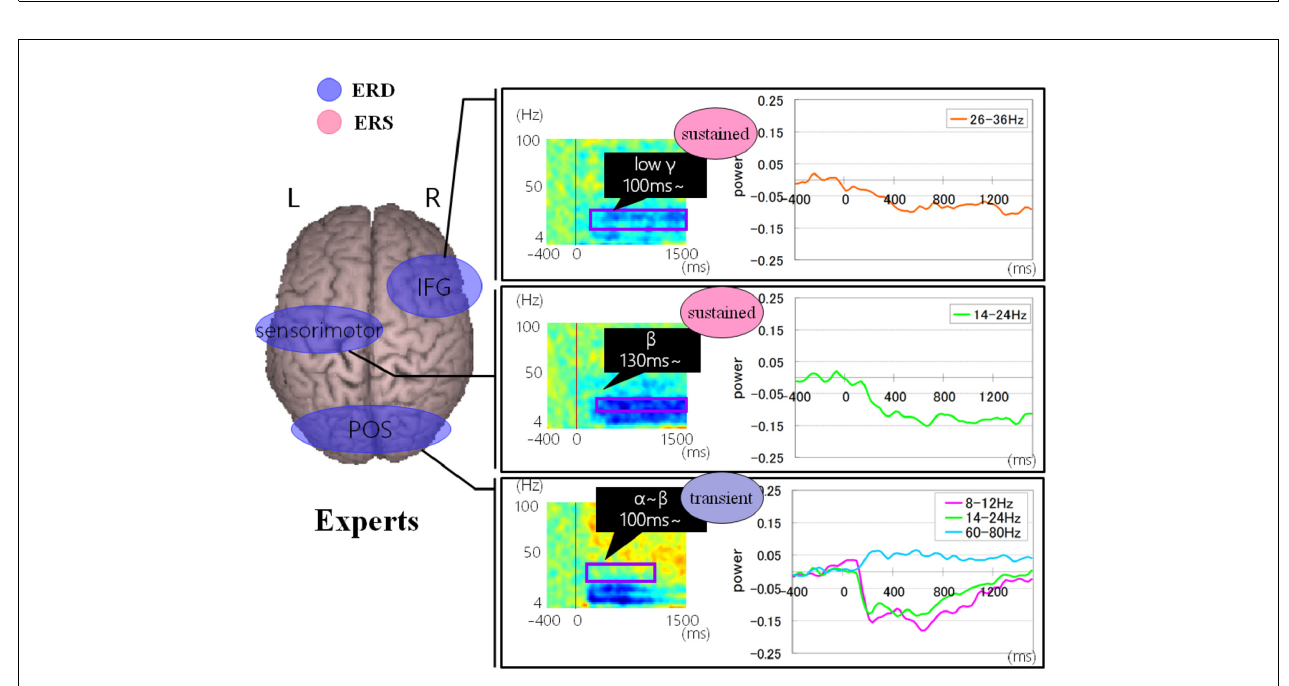
FIGURE 10 | A group average of time-frequency analyses in Abacus experts during the mental multiplication experiment. The time window is between − 400 and 1,500 ms; the movement onset is at 0 ms, and the frequency interval ranges from 4 Hz to 100 Hz. The red areas in the time-frequency maps indicate increases in the high gamma power (ERS), and the blue areas indicate decreases in the beta/alpha/low gamma power (ERD).